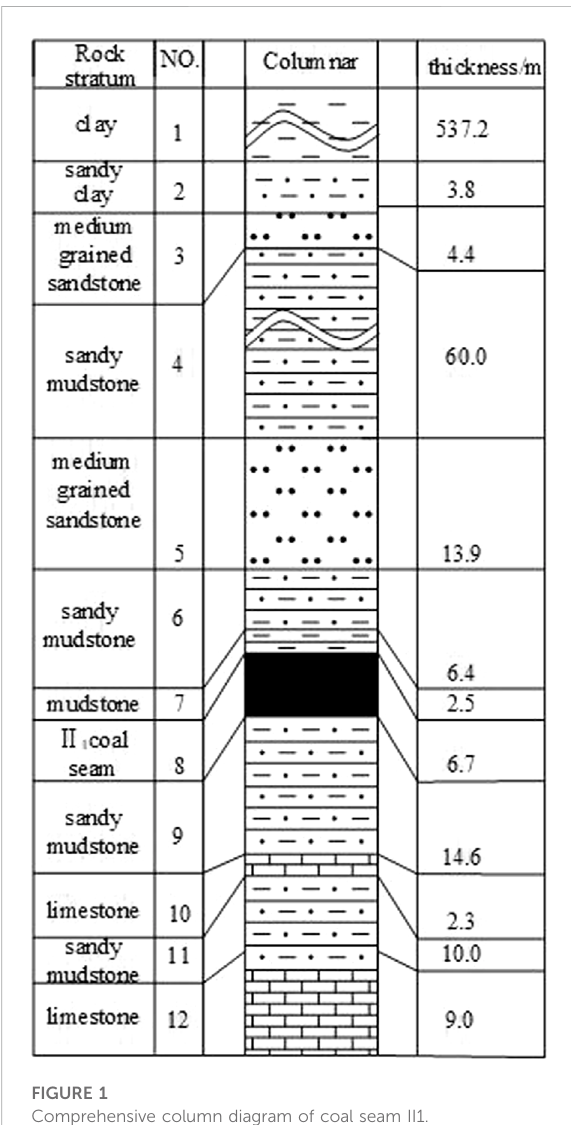
FIGURE 1 Comprehensive column diagram of coal seam